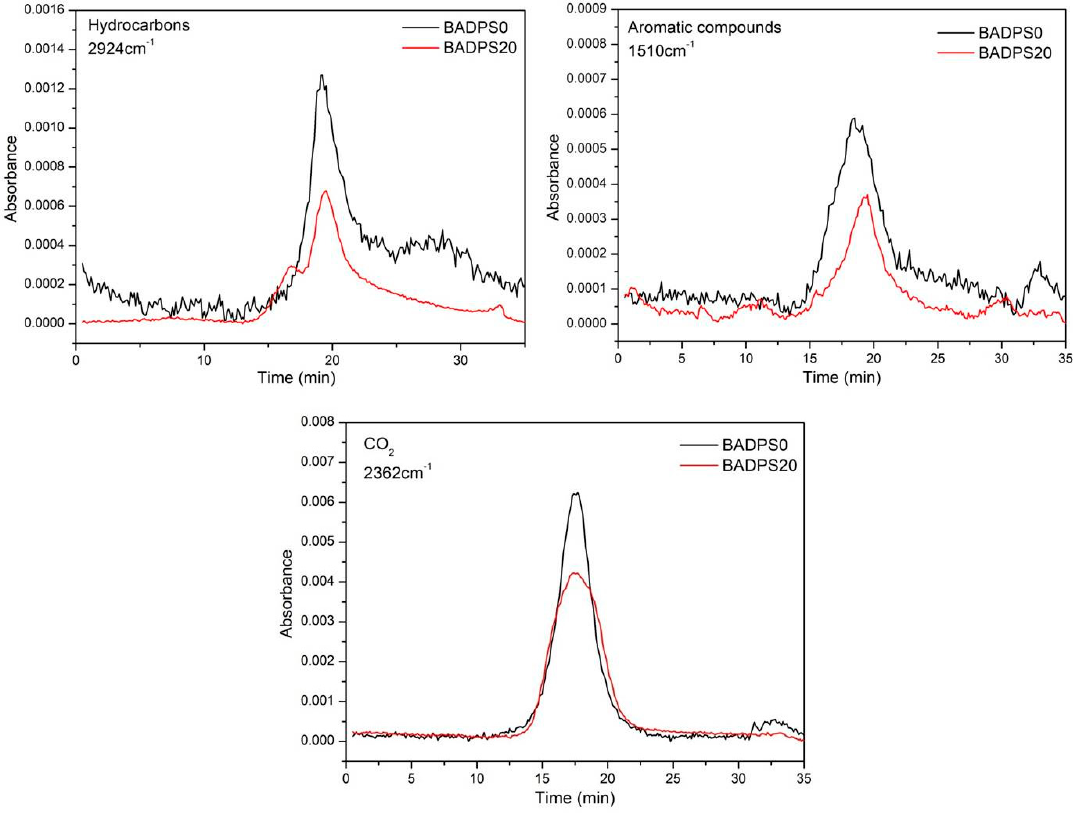
Figure 12. TG-FTIR spectra of pyrolysis products for BADPS0 and BADPS20.